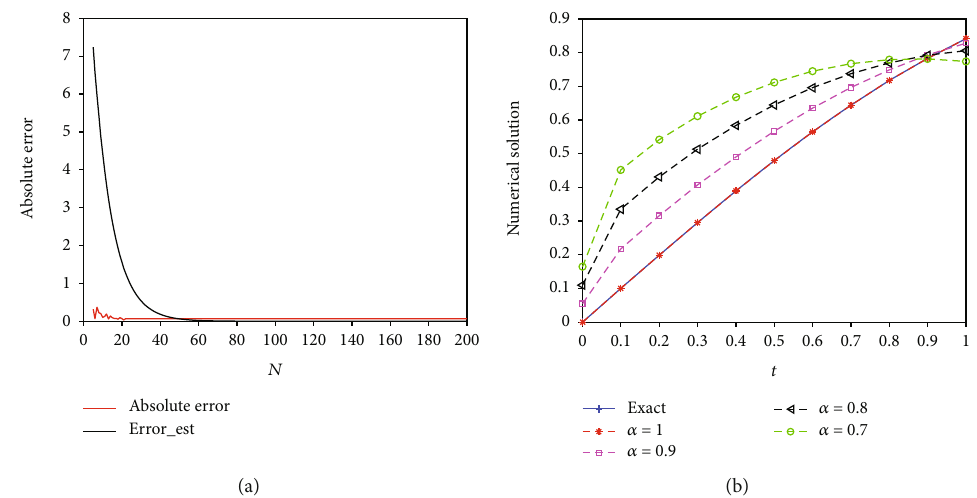
Figure 2: In (a), the absolute error versus error estimate corresponding to Problem 1 for β = 1 is shown. From the fi gure, we see that the observed error agrees with the error estimate. In (b), the plots of approximate solutions for various β are shown. Table 3: The approximate solutions for various values of β using the two numerical schemes corresponding to Problem 2.